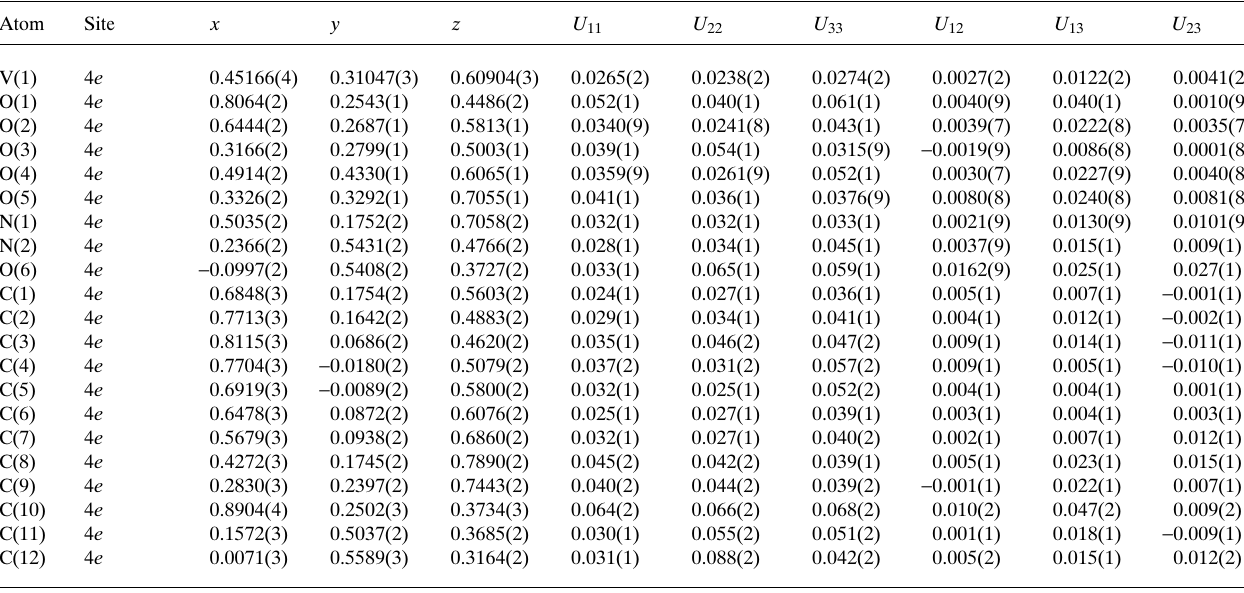
Table 3. Atomic coordinates and displacement parameters (in Å 2 )